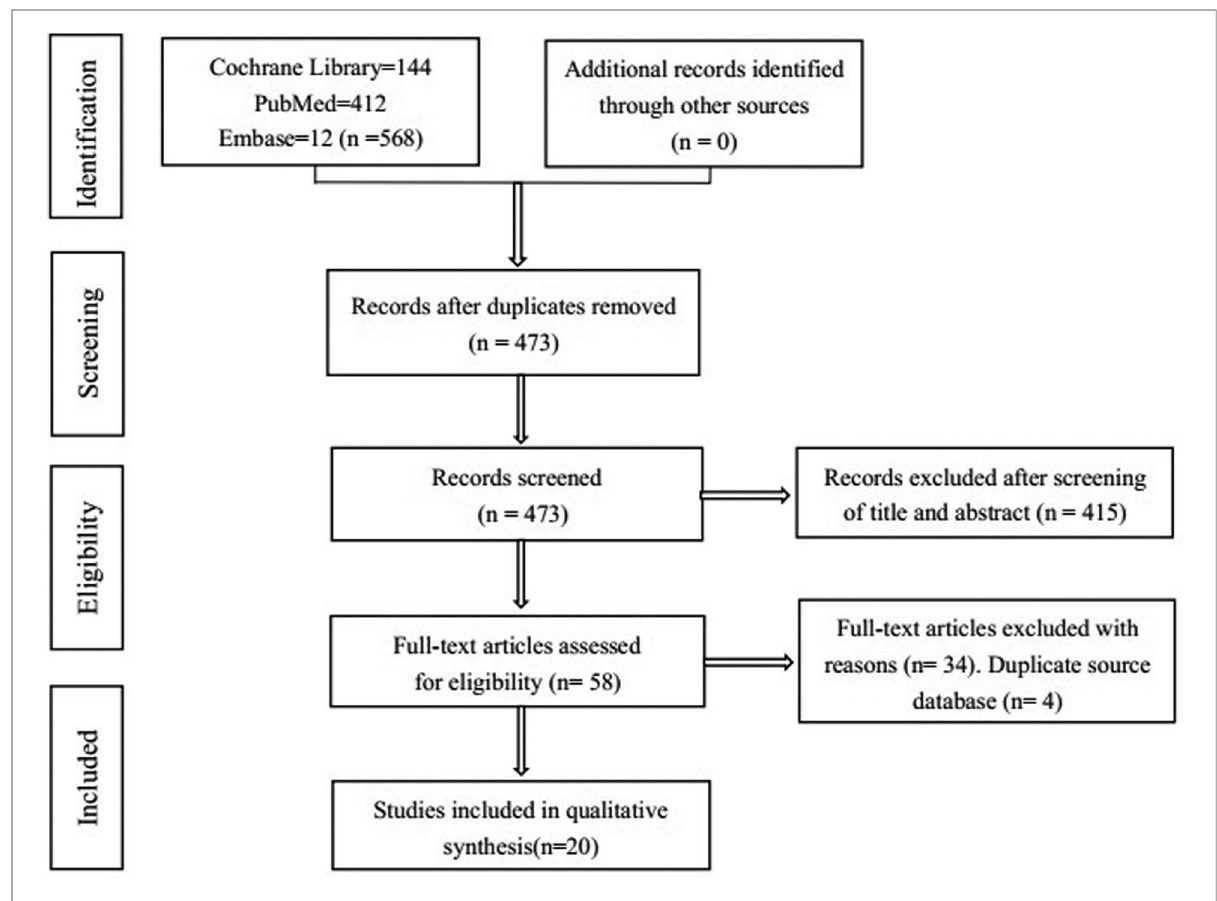
FIGURE 1 Flow charts of the study selection process for the meta-analysis of outpatient vs inpatient